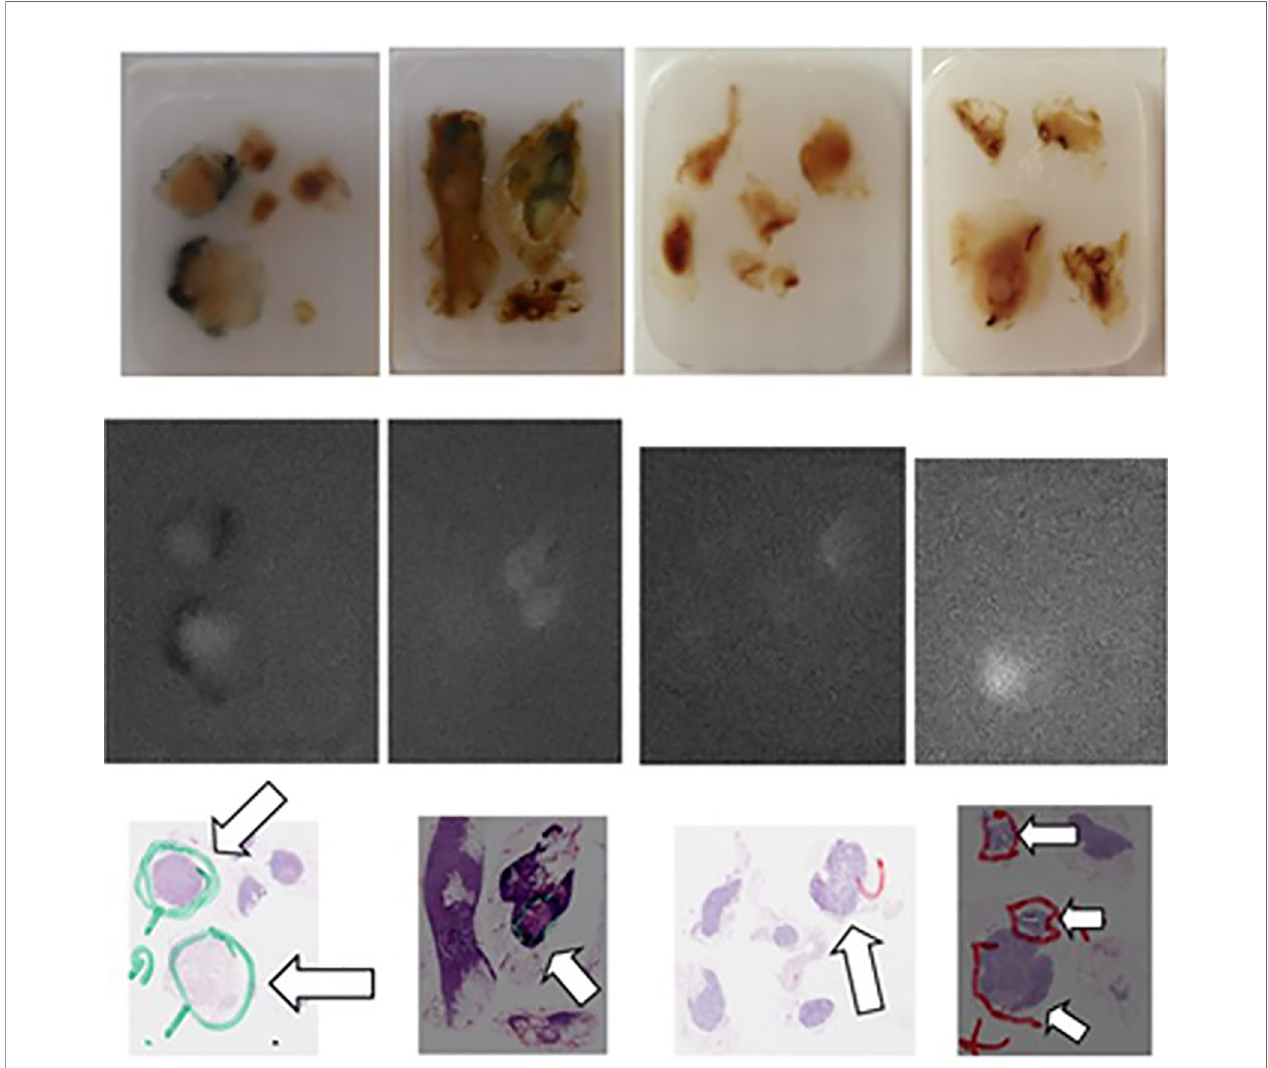
FIGURE 4 | Comparison of the “ real ” images (upper panel), of the fl uorescence images (mid panel) and of the corresponding AP slices of pN+ lymph nodes (arrows) embedded in paraf fi n obtained, from left to right, in patient n° 11 (two fi rst series), in patient n° 18 (third series), and in patient n° 19 (fourth series) from Group